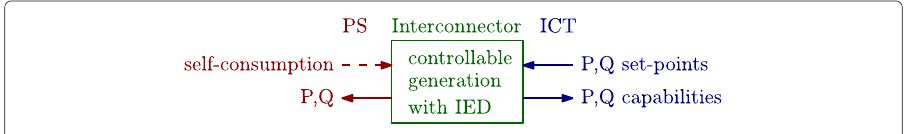
Fig. 2 Interconnector example: controllable